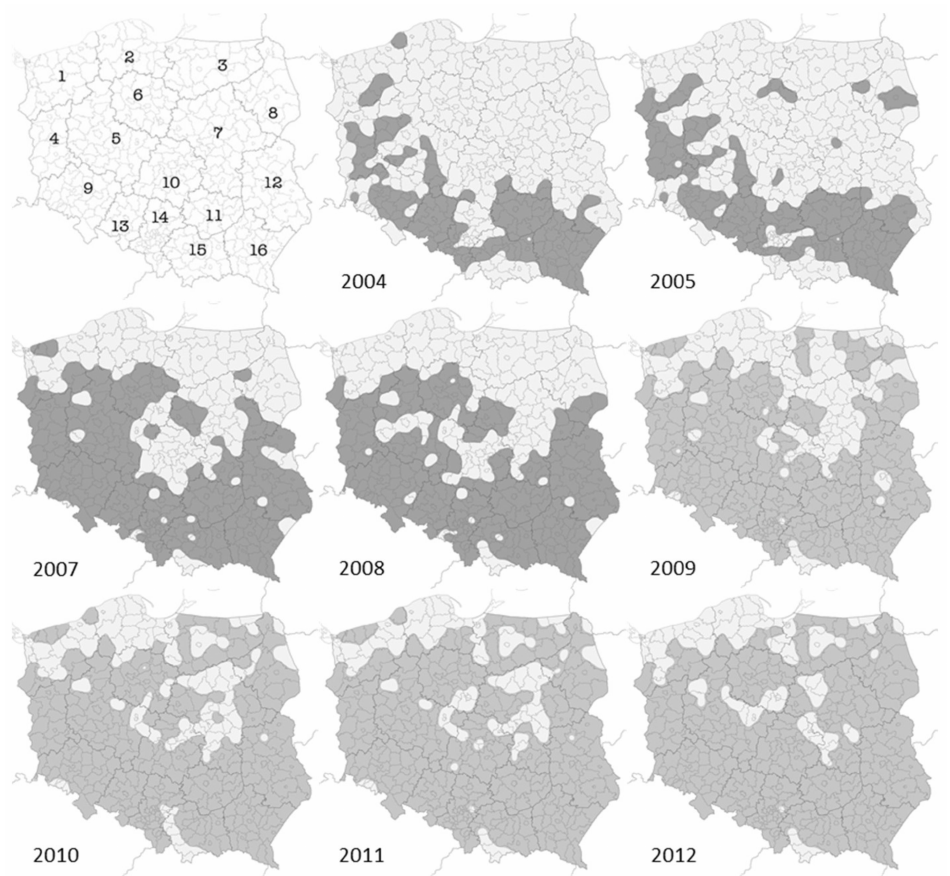
Figure 11. Stages of expansion of Ostrinia nubilalis in Poland (grayed out areas) identified as part of the national monitoring of this species carried out by the State Plant Health and Seed Inspection